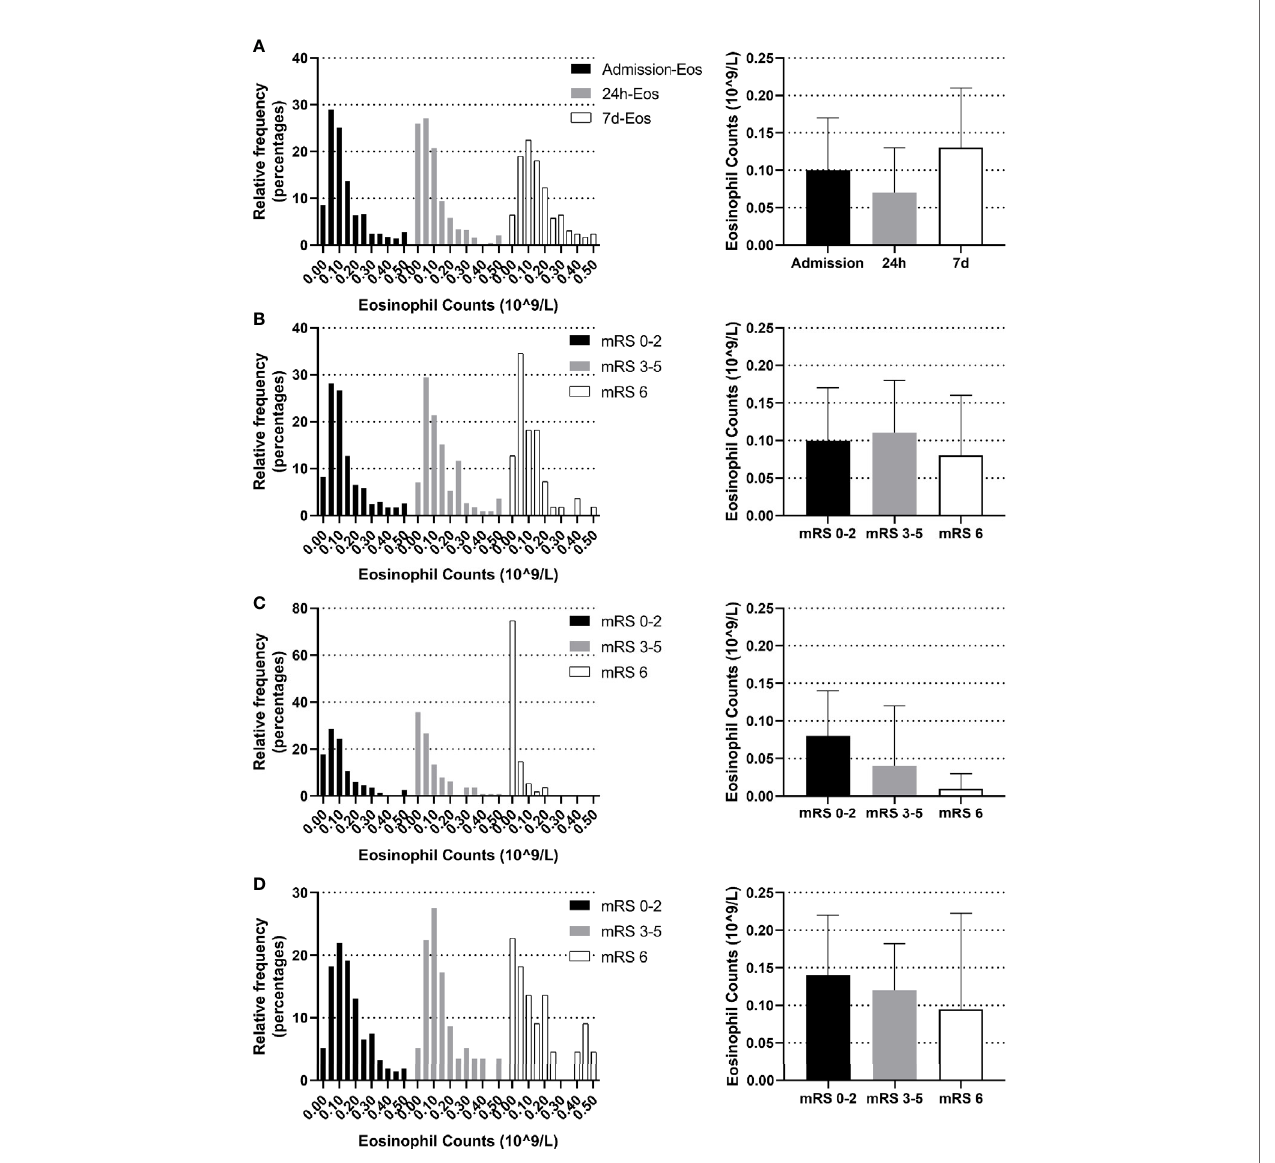
FIGURE 2 | Temporal pro fi le of eosinophil in AIS patients treated with r-tPA intravenous thrombolysis (A) Temporal pro fi le of eosinophil on admission, within 24 h after intravenous thrombolysis and the seventh day (B) Distribution of admission eosinophil according to 3-month mRS scores. (C) Distribution of 24 h-eosinophil according to 3-month mRS scores. (D) Distribution of 7 d-eosinophil according to 3-month mRS scores. Frequency distribution charts (eosinophil >0.5 were included in the group with bin center = 0.5) and bar graphs (median and interquartile range) were